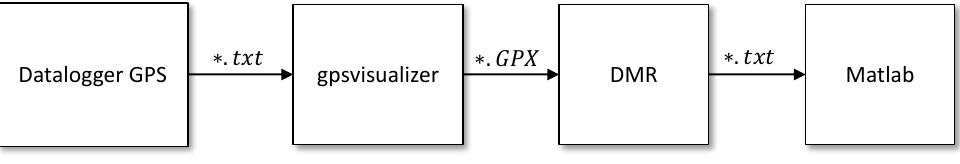
Figure 8. GNSS data conversion